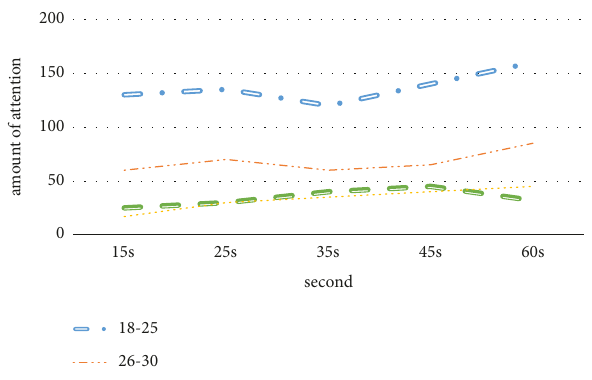
Figure 7: The amount of attention of users in different age